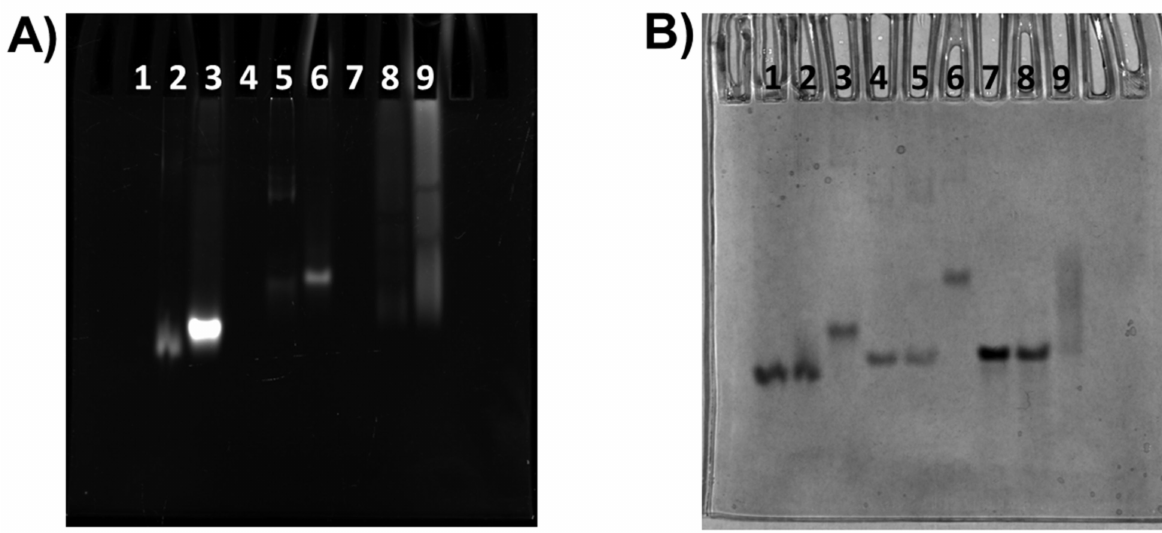
Figure 4. Native PAGE experiments. Oligonucleotide samples were loaded at 6 µ M concentration in 100 mM aqueous KCl and 20 mM potassium phosphate buffer (pH 7) and resolved on 20% native PAGE. Lane 1: free m-tel24 G-quadruplex. Lane 2: m-tel24/ c ex -NDI , 1:1. Lane 3: m-tel24/ c ex -NDI , 1:6. Lane 4: free M2 G-quadruplex. Lane 5: M2/ c ex -NDI , 1:1. Lane 6: M2/ c ex -NDI , 1:6. Lane 7: free ds12 duplex. Lane 8: ds12/ c ex -NDI , 1:1. Lane 9: ds12/ c ex -NDI , 1:6. Gel was visualised by exploiting ( A ) the intrinsic fluorescence of the c ex -NDI and ( B ) Stains-All